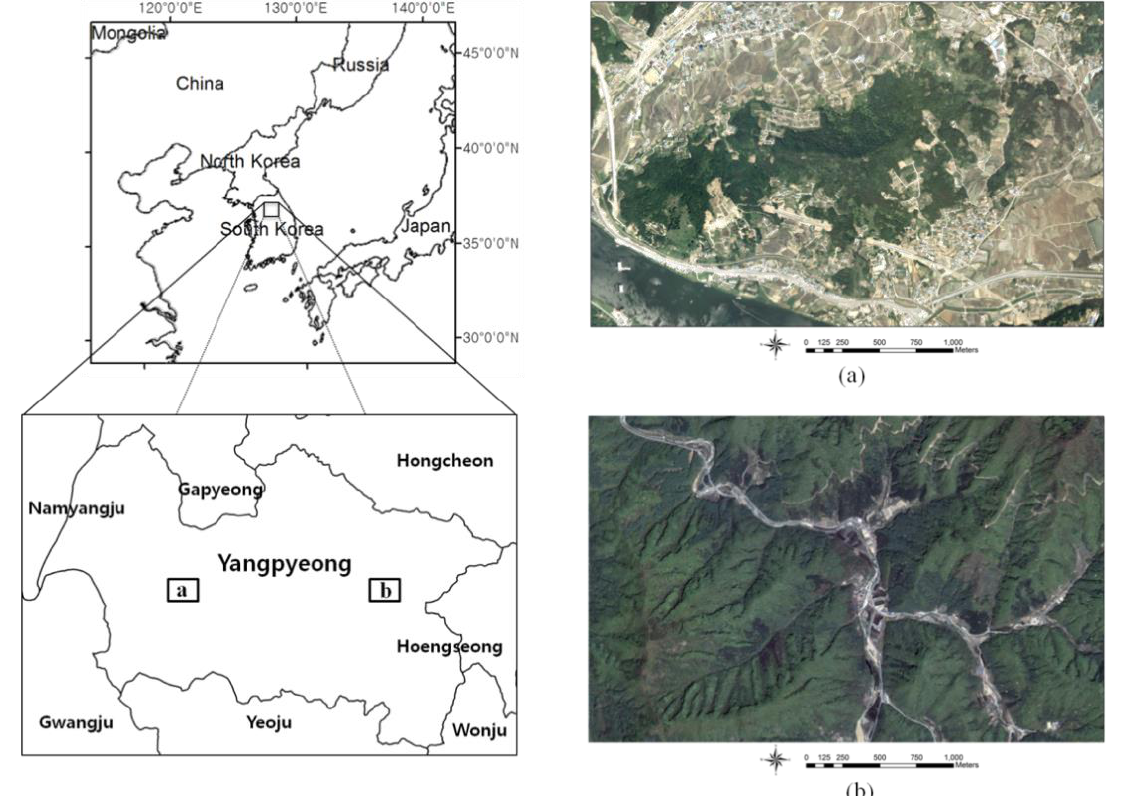
Figure 1. Geographical location of study area with digital aerial photographs. ( a ) Obin-ri; ( b ) Korea University Yangpyeong Experimental